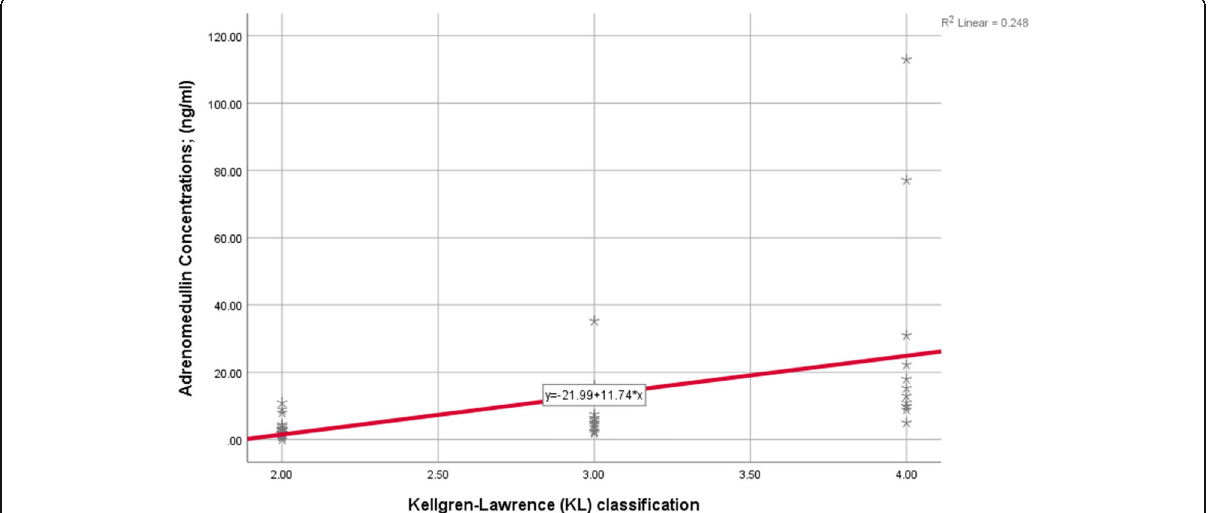
Fig. 3 Correlation between the Kellgren-Lawrence (KL) classification and serum Adrenomedullin concentrations among studied OA